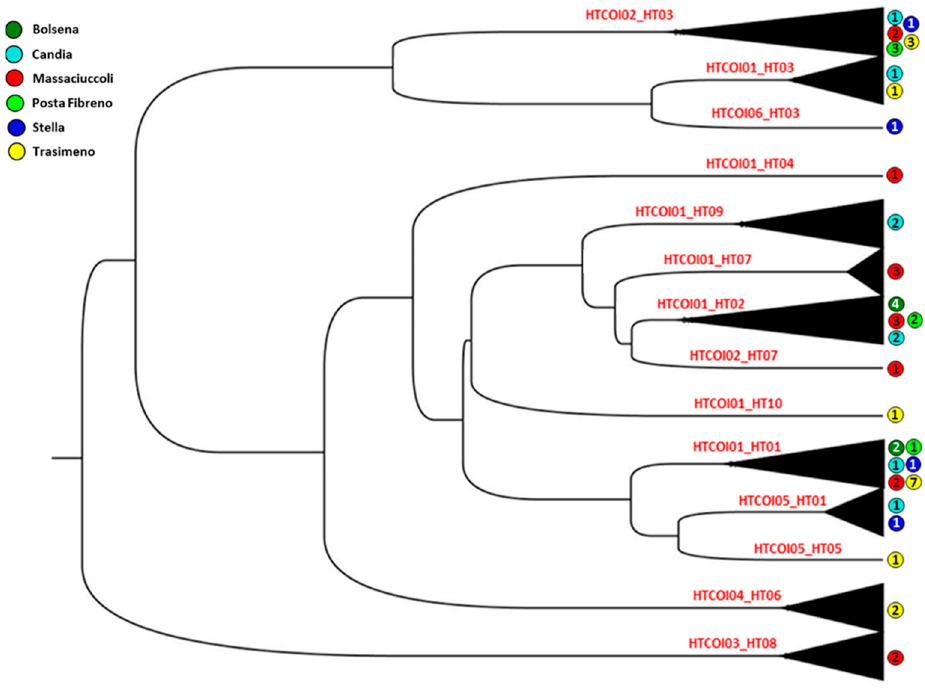
Figure 5. Bayesian phylogenetic tree based on concatenated mtDNA (COI and CR) haplotypes of six P. clarkii populations. Number of samples from the relative site is reported in each circle. Haplotype codes as in Table S5.